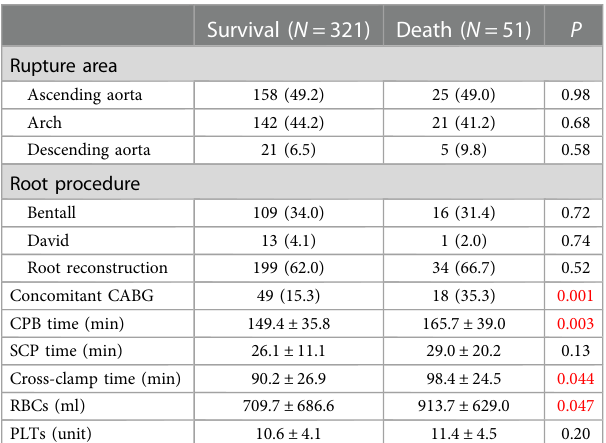
TABLE 2 Intraoperative results.